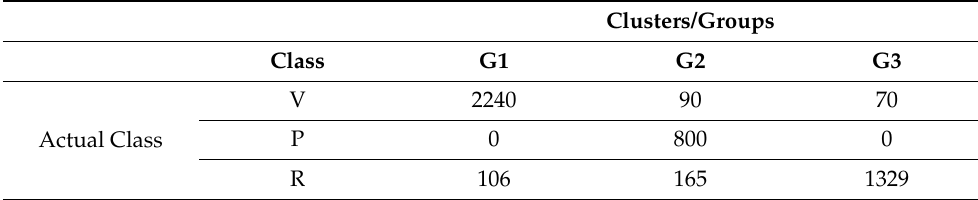
Table 4. Example of cluster